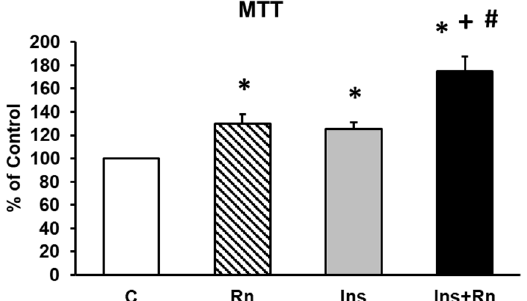
Figure 1. Effect of Ins and Rn on astrocytes in primary culture. Cell viability was determined by MTT assay in cells treated for 24 h. Astrocytes were incubated without Ins or Rn (control, C), with Rn (10 − 6 M), with Ins (10 − 8 M), or with Ins + Rn (10 − 6 M + 10 − 8 M). Data are mean ± SD of four independent experiments (four different rats). * p < 0.05 vs. control. + p < 0.05 vs. Rn. # p < 0.05 vs.